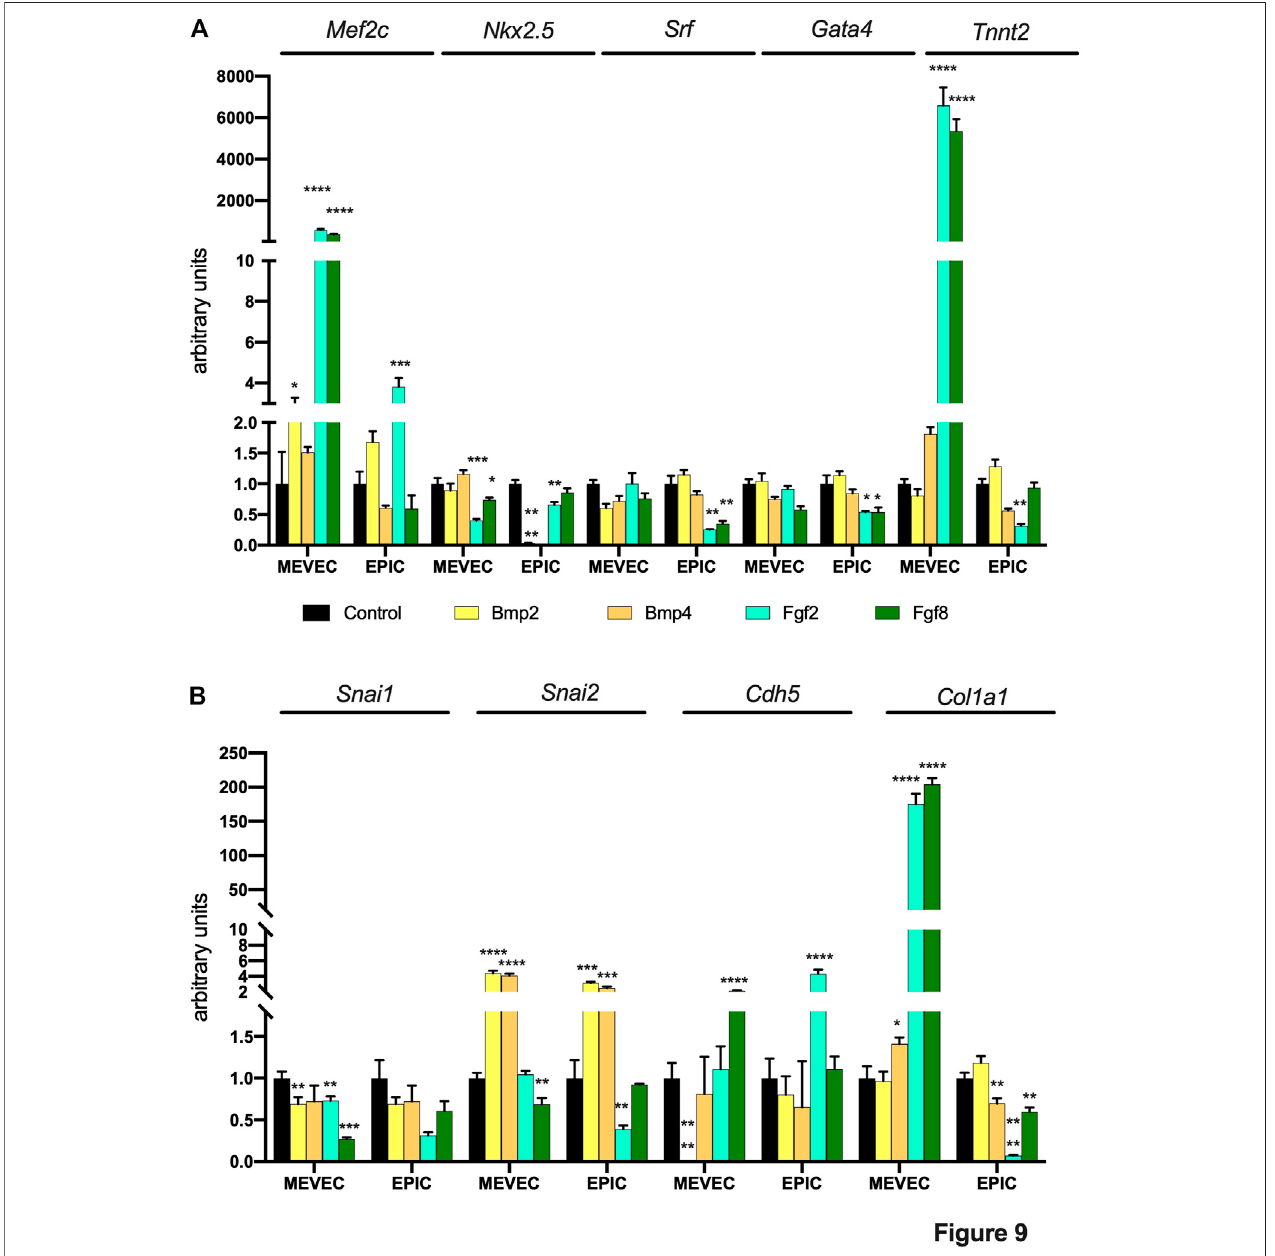
FIGURE 9 | Panel (A) RT-qPCR analyses of Mef2c, Nkx2.5, Srf, Gata4 and Tnnt2 expression after control, Bmp2, Bmp4, Fgf2 and Fgf8 treatments in MEVEC (endocardial) and EPIC (epicardial) cell lines, respectively. Panel (B) RT-qPCR analyses of Snai1, Snai2, Cdh5 and Col1a1 expression after control, Bmp2, Bmp4, Fgf2 and Fgf8 treatments in MEVEC (endocardial) and EPIC (epicardial) cell lines, respectively. * p < 0.05, ** p < 0.01, *** p < 0.001, **** p < 0.0001.